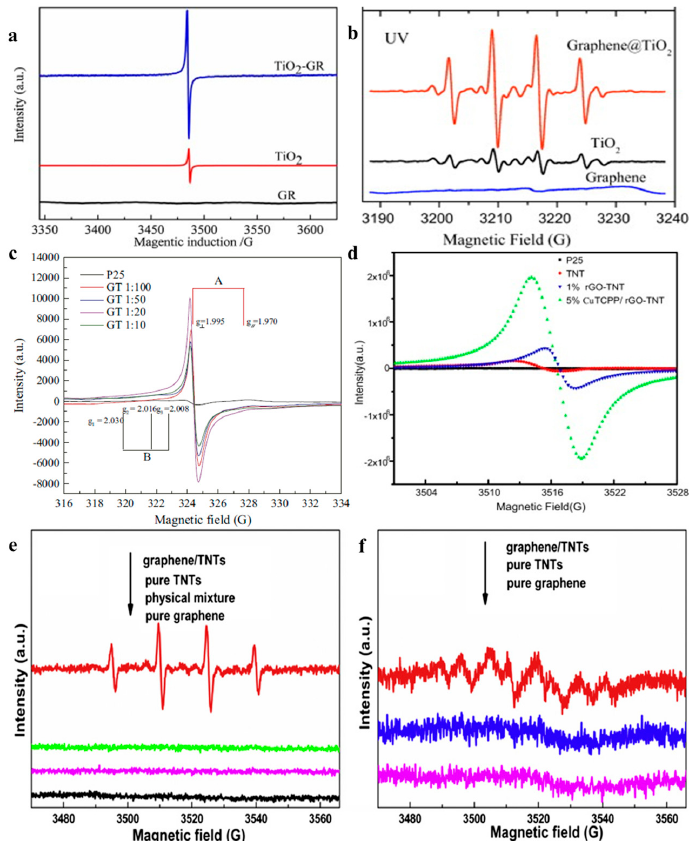
Figure 7. Under UV-light irradiation, the EPR curves (DMPO- OH · ) of TiO 2 and the graphene-TiO 2